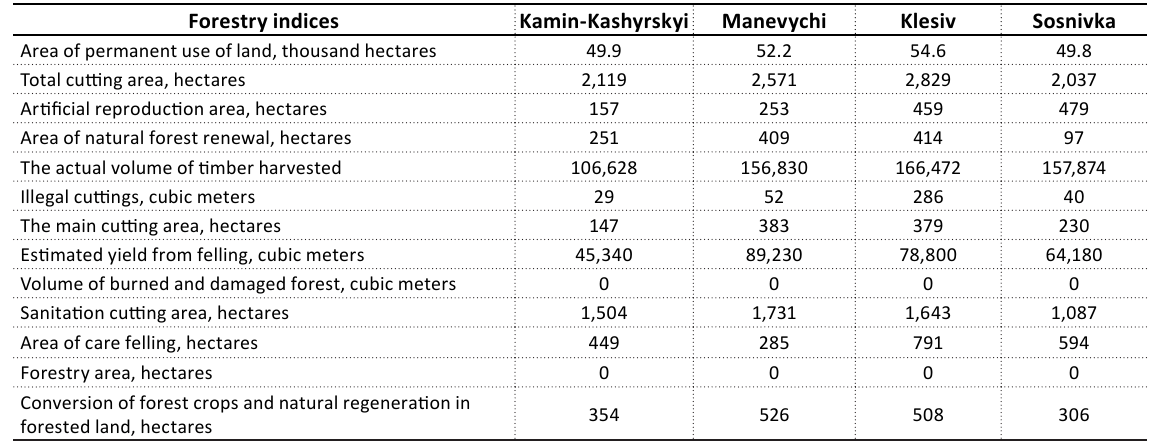
Source: According to the company’s reporting documentation.